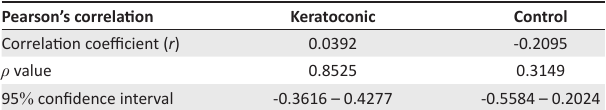
TABLE 3: Mann-Whitney U test presenting the test statistics and significance levels for both the keratoconic and the control groups. Mann-Whitney U test